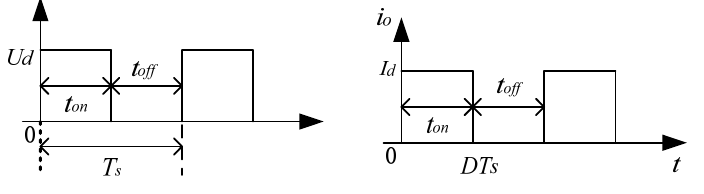
Figure 3. Waveform of voltage and current on load.